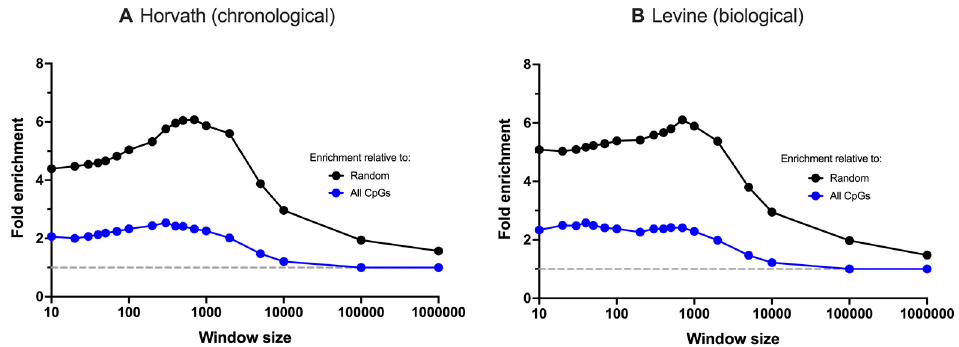
Figure 3. Enrichment of human G4 sequences at ( A ) Horvath chronological ageing clock and ( B ) Levine biological ageing clock. Curves are for enrichment relative to randomly shuffled G4 coordinates (black) or relative to enrichment of G4s at CpGs globally (blue). Dotted grey line at fold-enrichment =1 for reference.